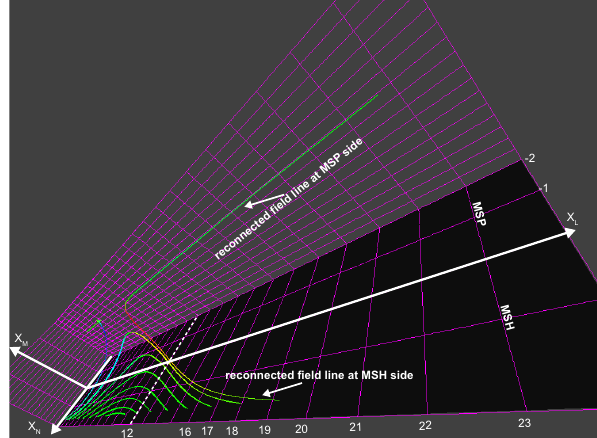
Fig. 8. Comparison between (a) B M and (b) V E × B ,M . Along the MSP SR, the enhanced E N makes enhanced V E × B ,M > 0 to be present. This means that the reconnected field are shifted in the +M direction upon crossing the SR and this happens only on the MSP